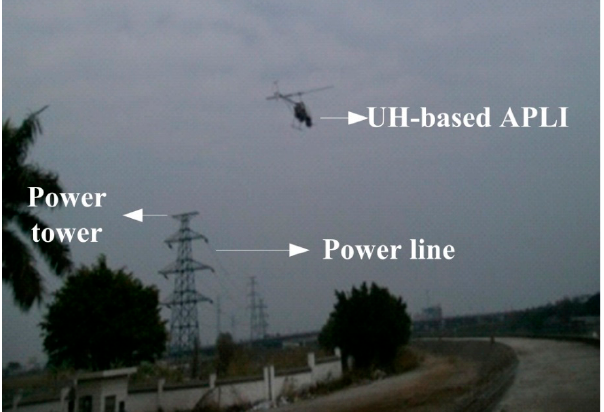
Figure 18. The picture of the experiments for a real UH -based APLI system.